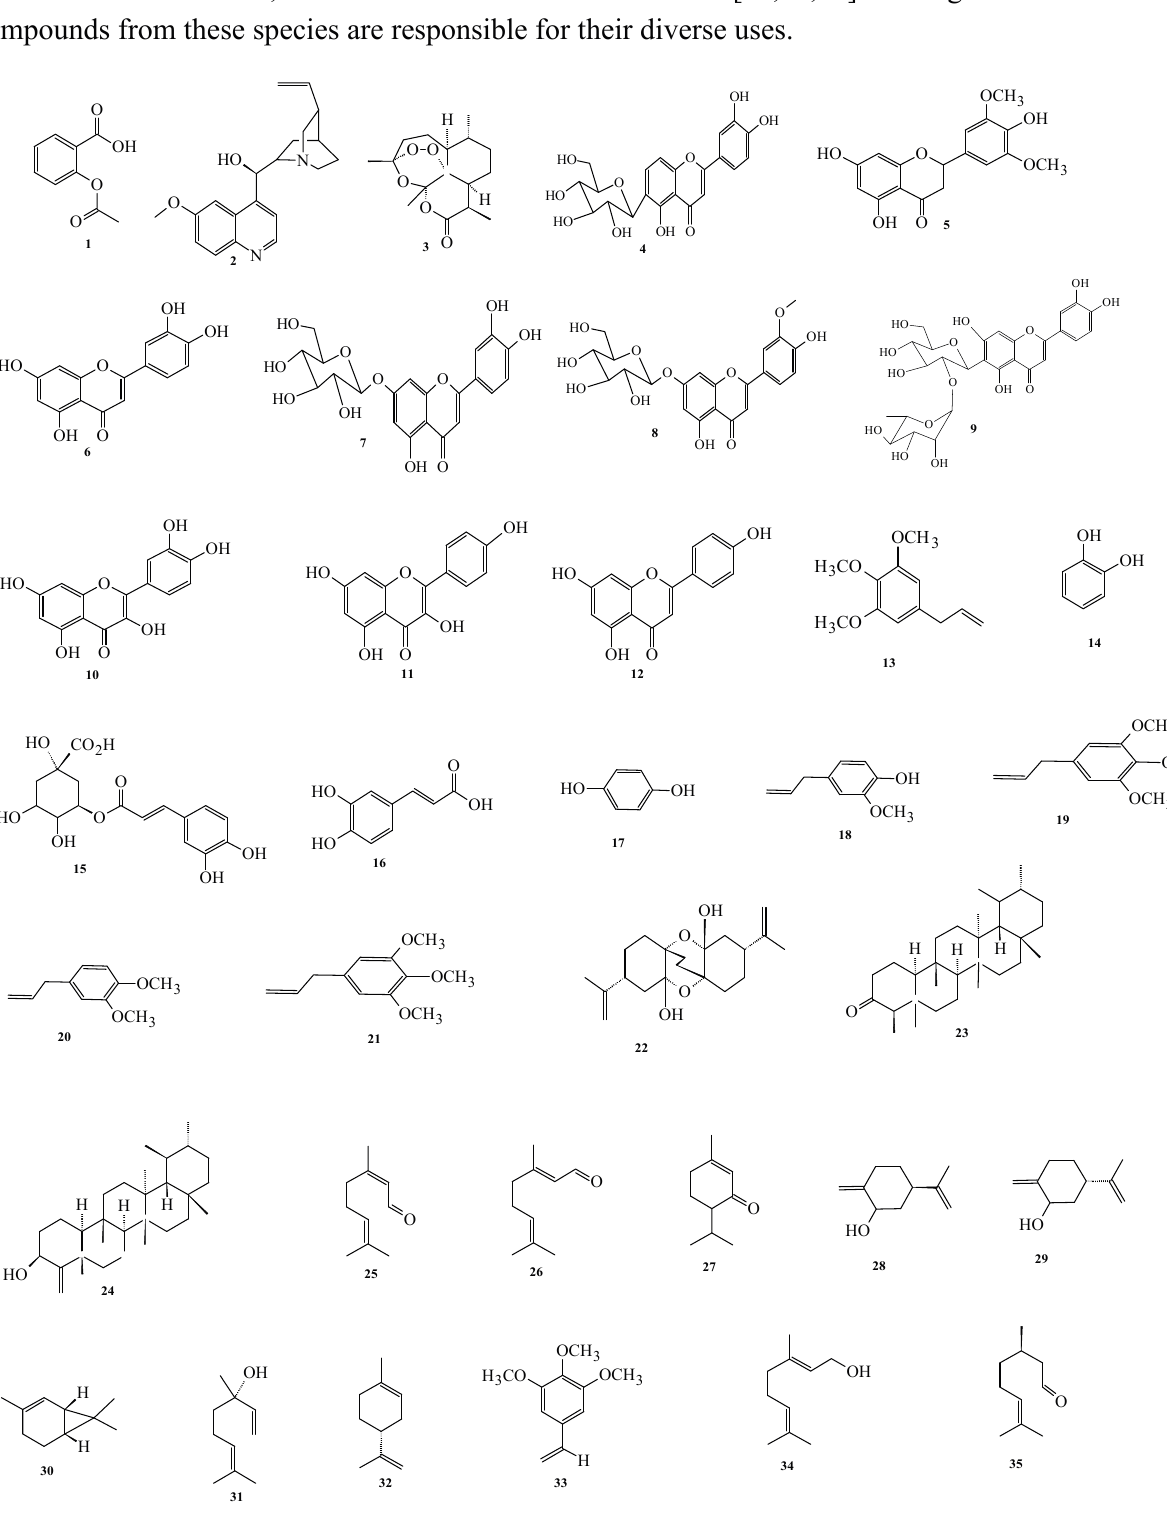
Figure 1. Flavonoids and triterpenoids from Cymbopogon